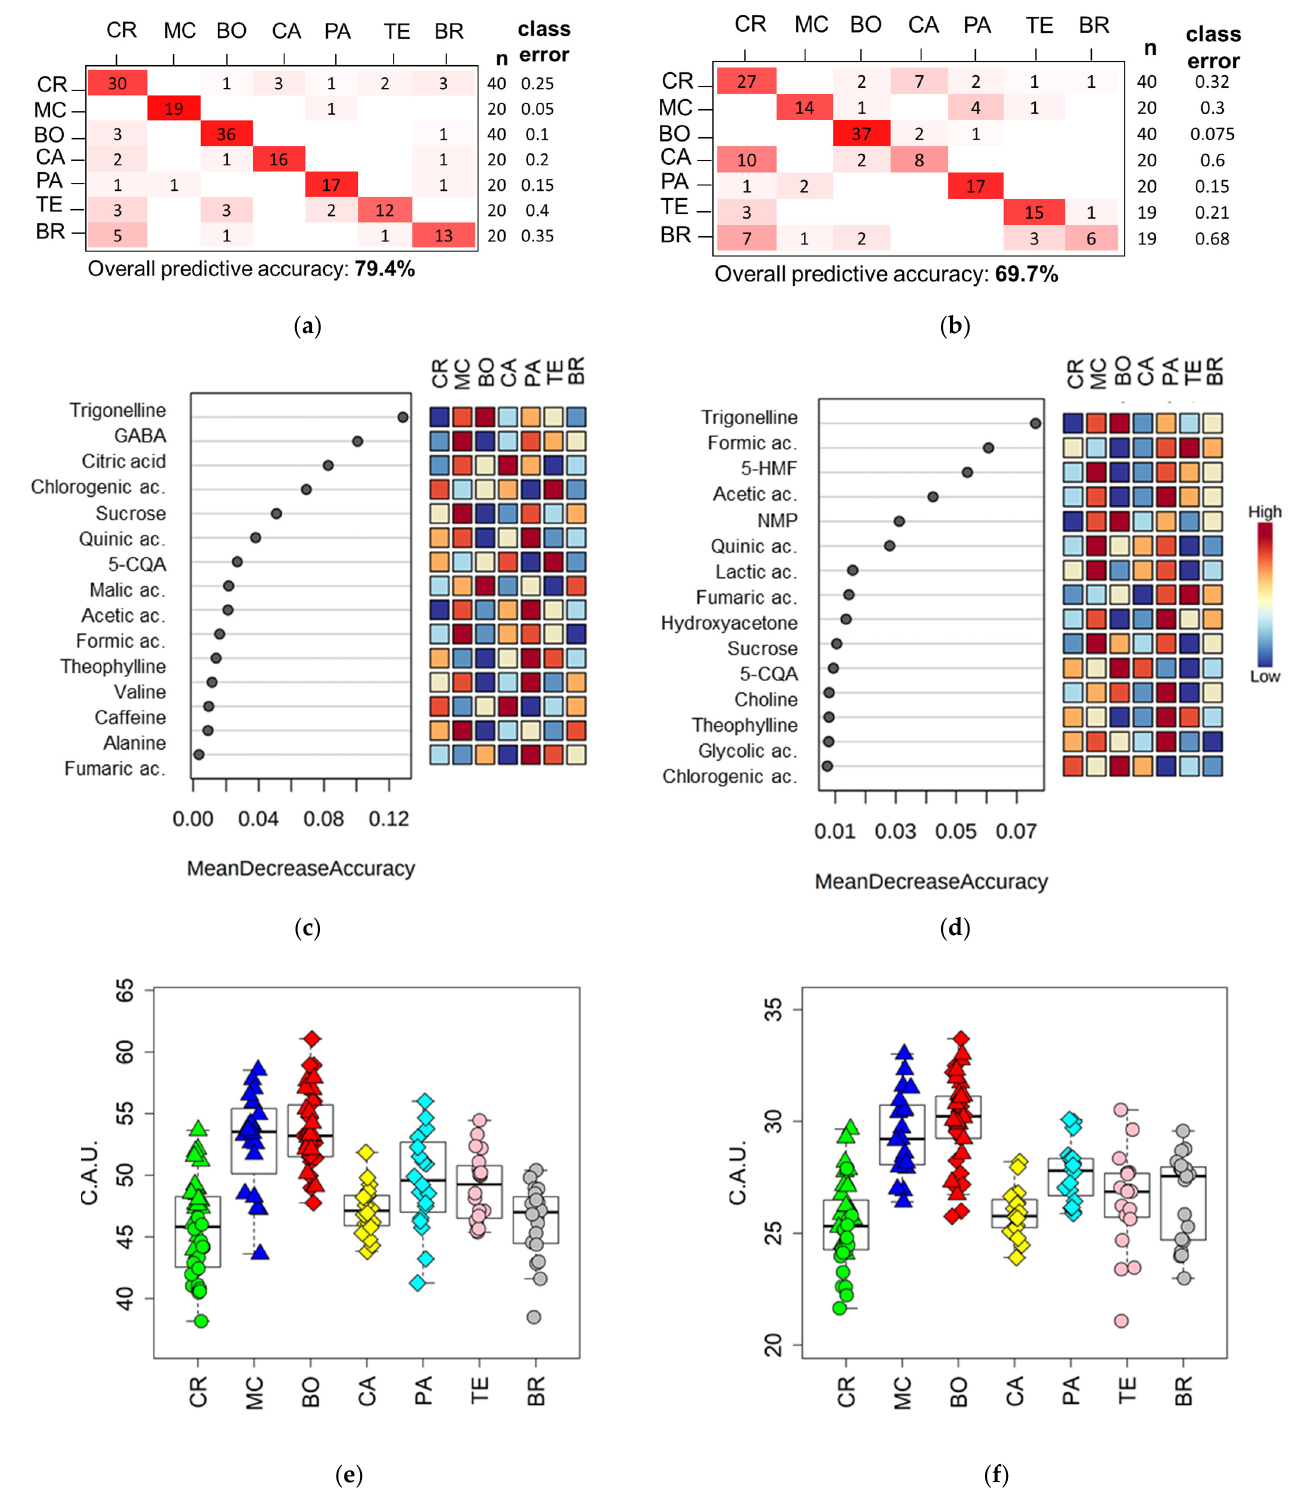
Figure 3. Variety profiling. Confusion matrices of RF algorithm of green ( a ) and roasted ( b ) metabolites of coffee beans. A summary of the variable importance measures for the identified metabolites with variety as the response variable in the RF model ( a ) of green coffee ( c ) and model ( b ) of roasted coffee ( d ). Metabolites are ranked according to the mean decrease in classification accuracy. At the bottom are reported the boxplots of the trigonelline levels in green ( e ) and roasted beans ( f ) among the seven different coffee varieties.